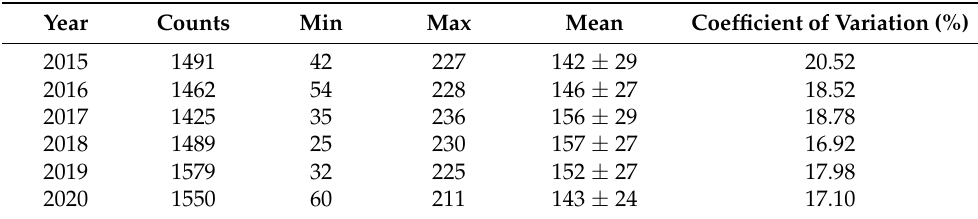
Table 1. Statistical data of the 90th percentile of the MDA8 from urban monitoring stations in mainland China (2015–2020) ( µ g/m 3 ) #